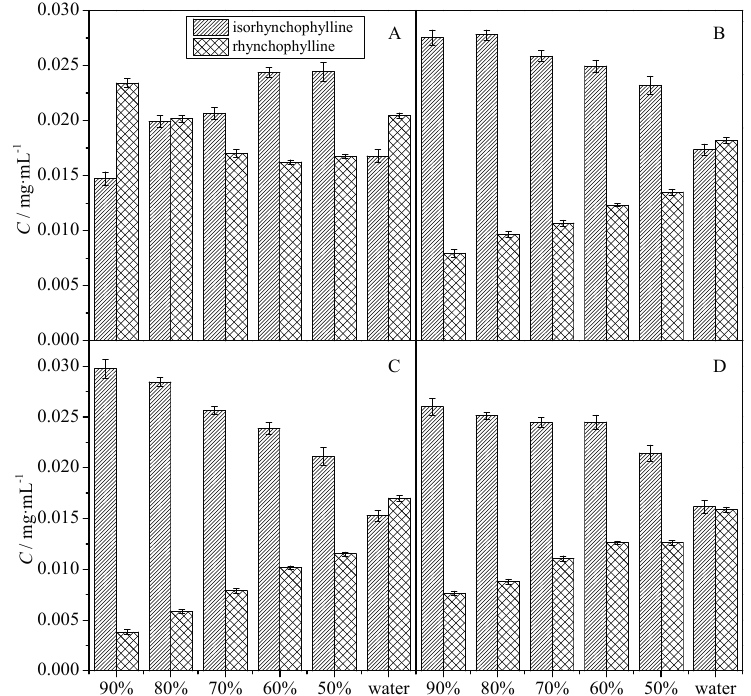
Figure 3. Effect of different solvent on the rate of conversion of RIN and IRN. ( A ) RIN reaction for 30 min at 80 °C; ( B ) RIN reaction for 300 min at 80 °C; ( C ) IRN reaction for 30 min at 80 °C; ( D ) IRN reaction for 300 min at 80